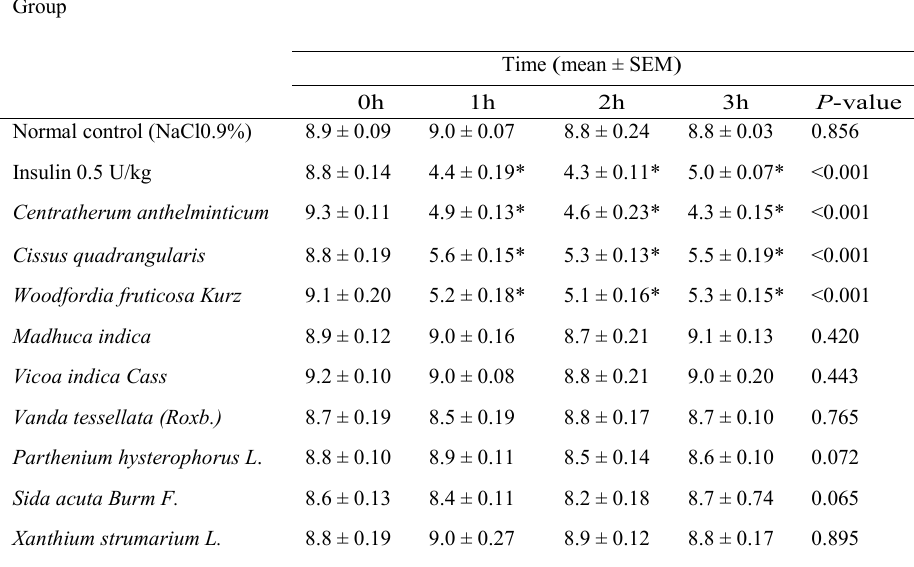
Table 2. Hypoglycemic activity of leaf extract by i.p. route in normal rats. Blood glucose levels(mmol/L)at different time points (h) Group Time (mean ± SEM) 0h 1h 2h 3h P -value Normal control